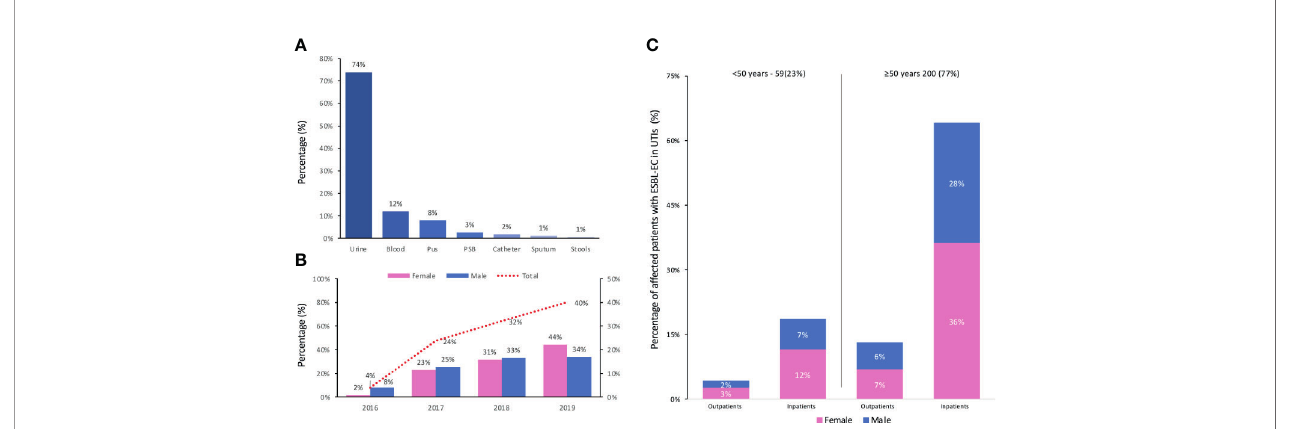
FIGURE 1 | (A) Prevalence of ESBL-EC from different clinical specimens; Protected specimen brush (PSB). (B) Evolution of urinary tract infections due to ESBL-EC (Male, Female and Total) per year (from 2016 to 2019). (C) Age distribution of the affected patients with ESBL-EC (Male/Female) in the outpatient and inpatient